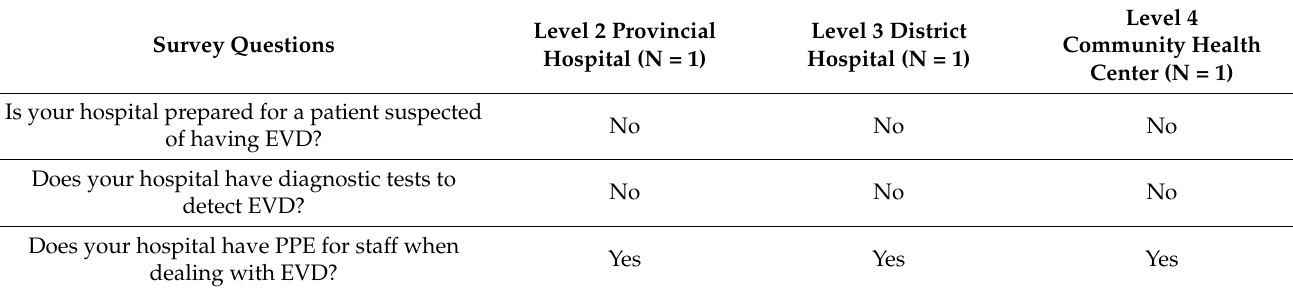
Table 8. Hospital preparedness for patients with Ebola virus